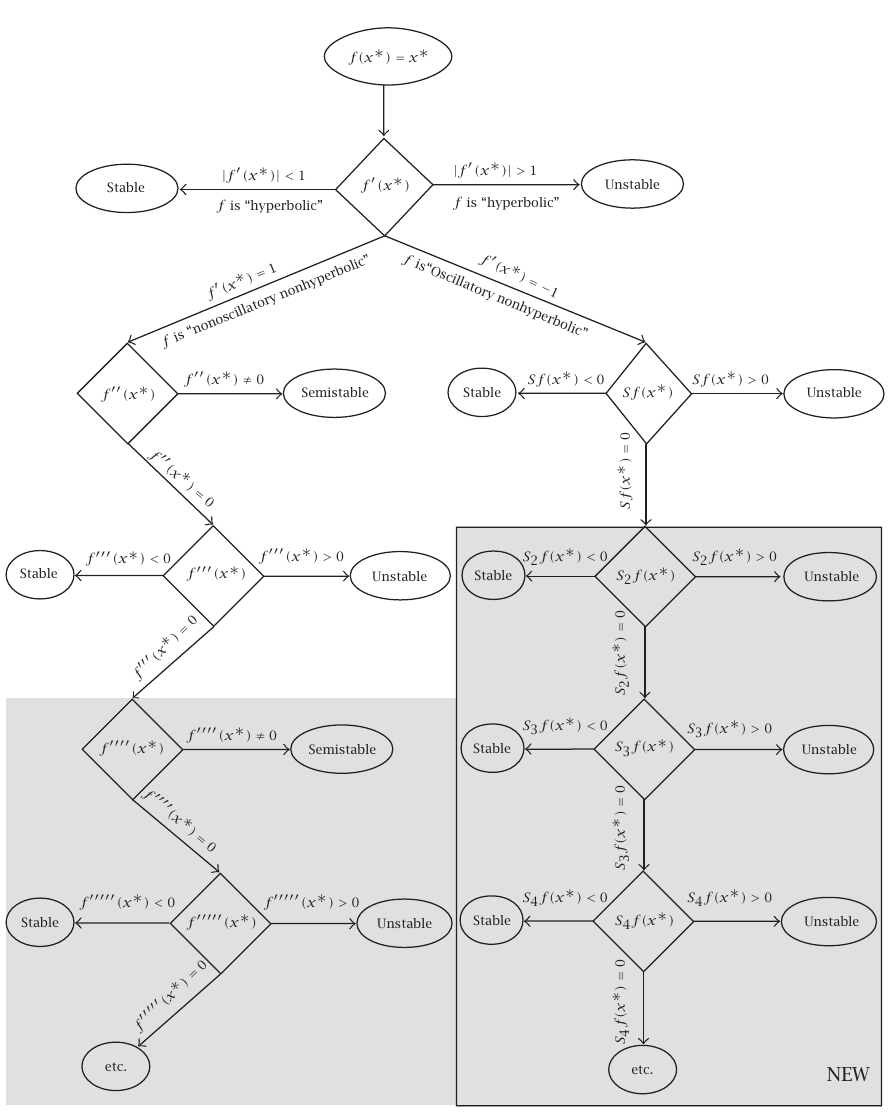
Figure 1.1 . Classification of fixed points of a one-dimensional